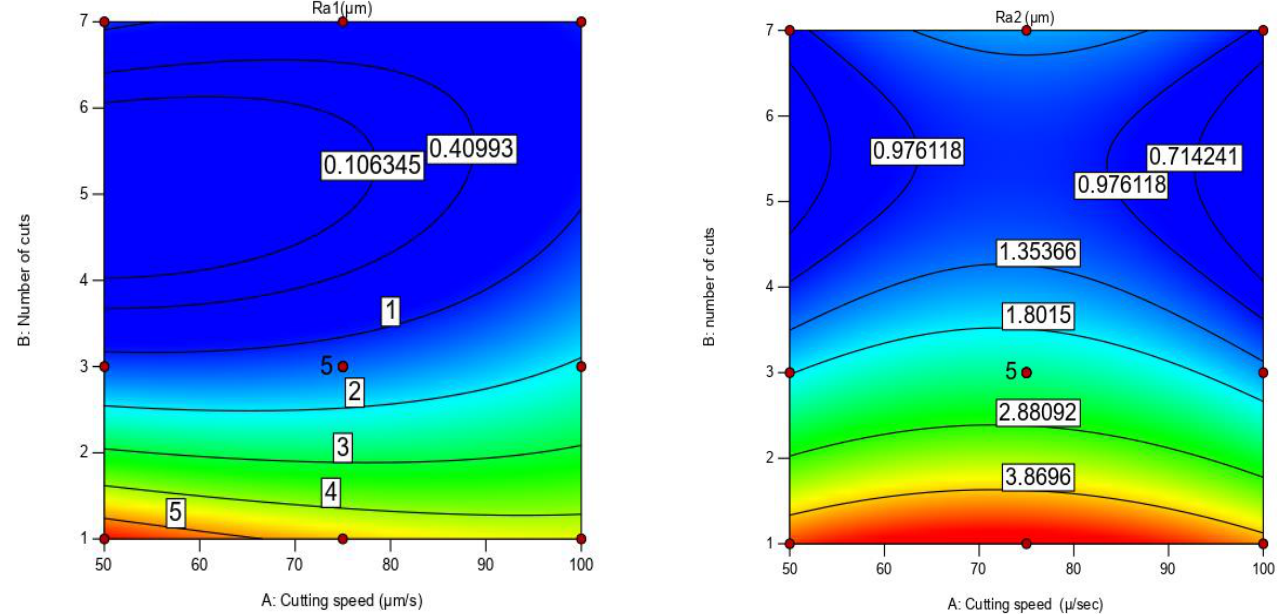
Figure 14. Effect of cutting process variables on surface roughness contour for Ti-6Al-4V (Ra 1 ) and Ti-6Al-7Nb (Ra 2 ) alloy.